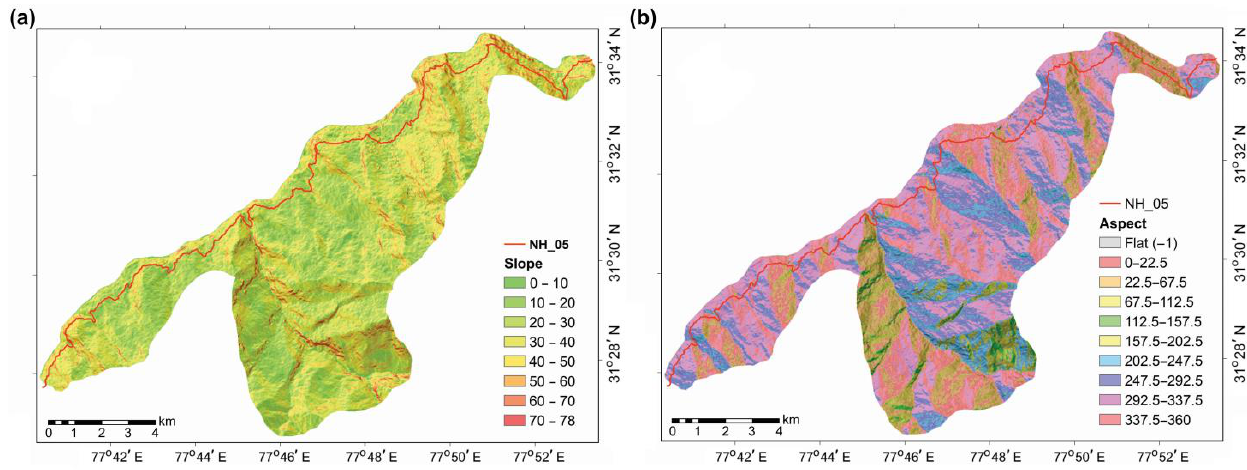
Figure 8. ( a ) Slope map of the area, ( b ) Aspect map of the area derived from DEM. The values in the legend are in